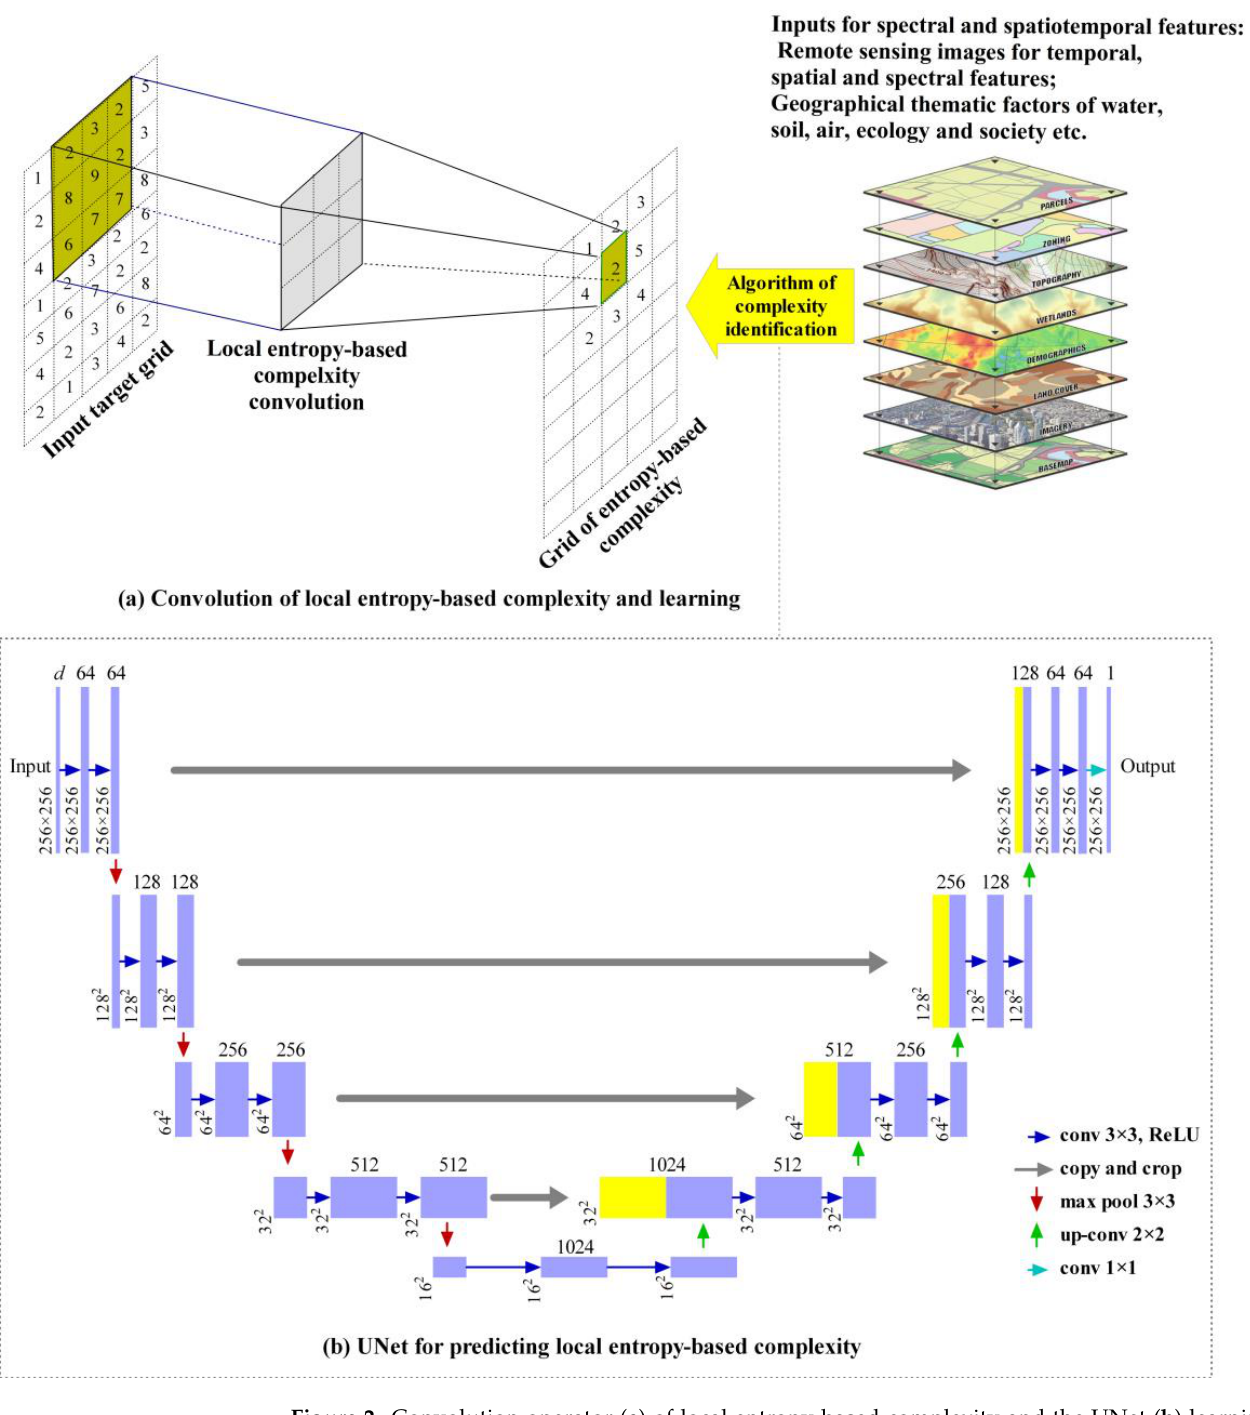
Figure 2. Convolution operator ( a ) of local entropy-based complexity and the UNet ( b ) learning algorithm to identify it.